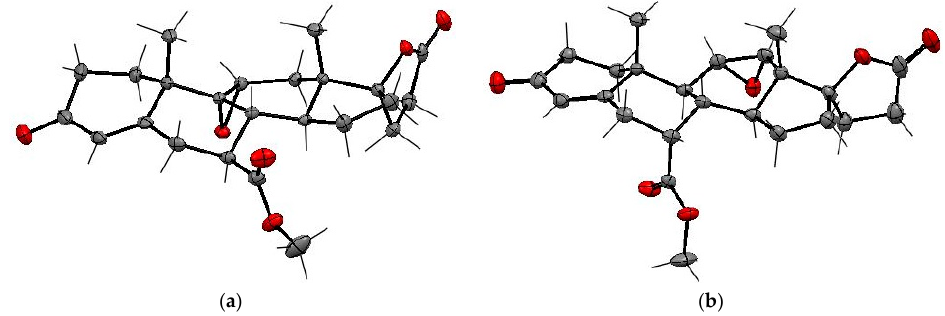
Figure 9. Molecular structure of the isomeric epoxides: ( a ) (7 β ,11 α ,17 α )-9,11-epoxy- 2a and ( b ) (7 α ,11 α ,12 α ,17 α )-11,12-epoxy- 2b . Table 9. Summary of crystallographic data and structure refinement for the isomeric (7 β ,11 α ,17 α )-9,11-epoxyester 2a and (7 α ,11 α ,12 α ,17 α )-11,12-epoxyester 2b .